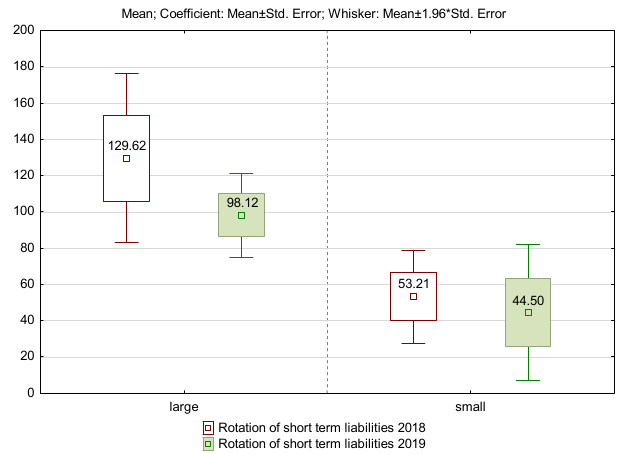
Risks 2022 , 10 , x FOR PEER REVIEW 9 of 16